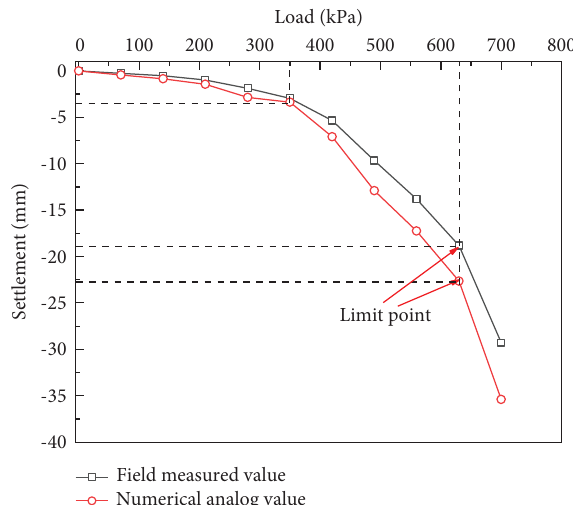
Figure 20: Comparison of numerical simulation and measured